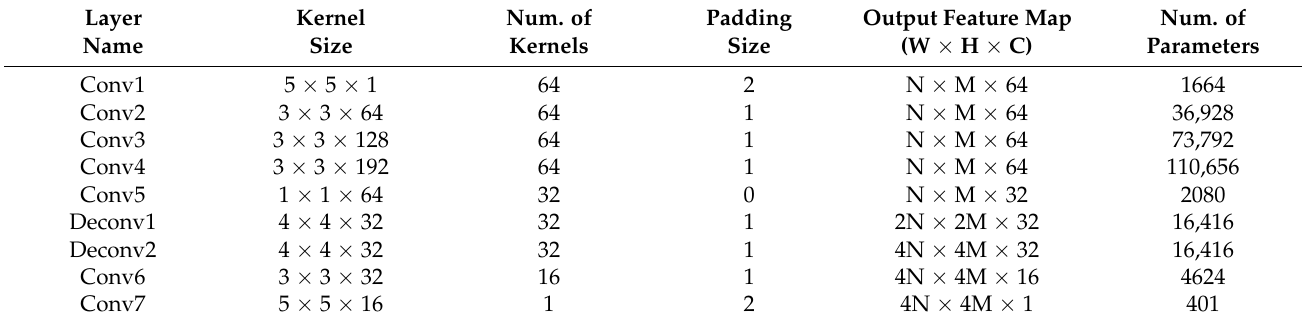
Table 2. Analysis of network parameters in SR-SLNN.